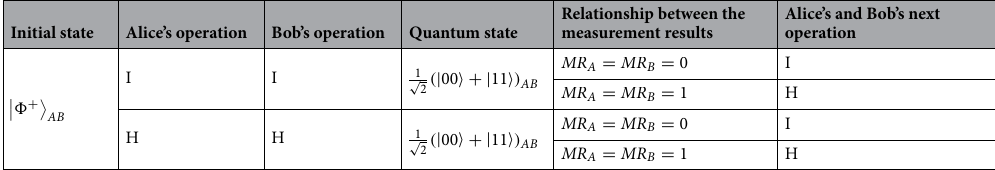
Initial state Alice’s operation Bob’s operation Quantum state